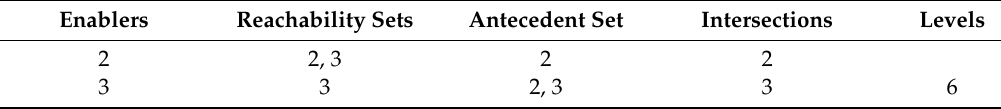
Table 11. Level partitions for enablers—Iteration 6.